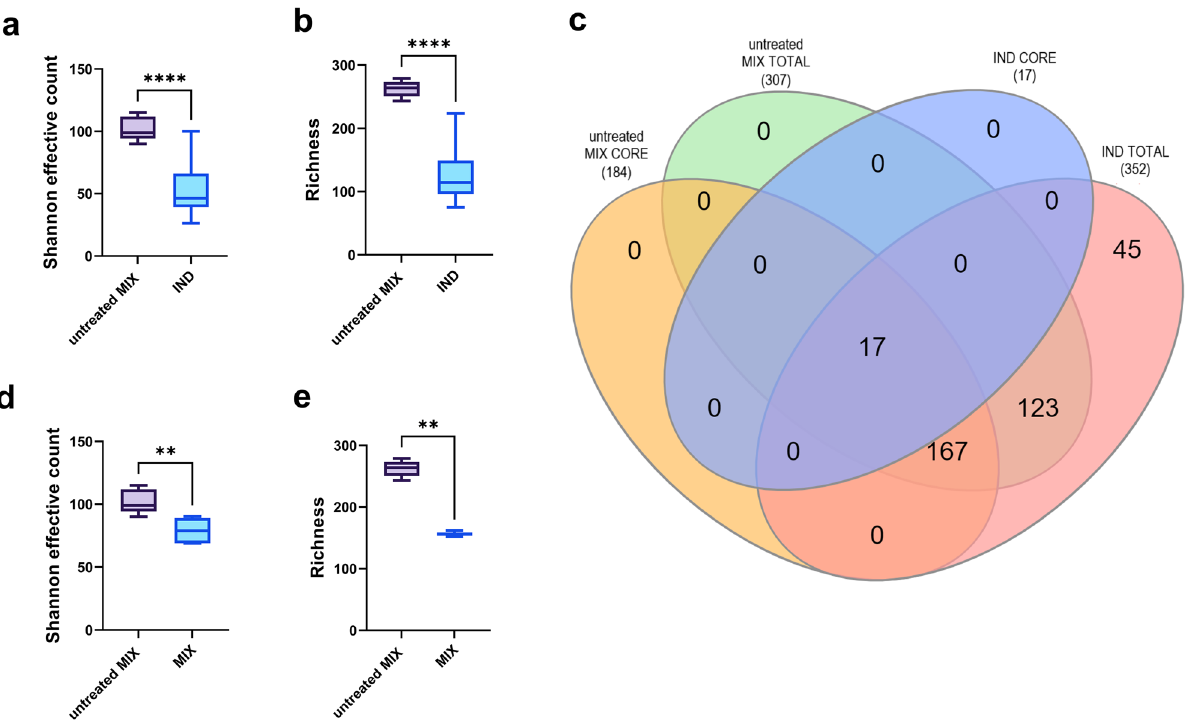
Figure 1. Community α -diversity is shown as ( a ) Shannon effective counts and ( b ) Richness between untreated MIX (n = 5) and IND (n = 15) groups. Core microbiota analysis is shown as ( c ) a Venn diagram depicting unique and shared ASVs between MIX (n = 5) and IND (n = 15) samples presented as a number of observed ASVs. Comparison of the MIX samples before (untreated MIX, n = 5) and after PMA treatment (MIX, n = 6) is shown as α -diversity by ( d ) Shannon effective count and ( e )